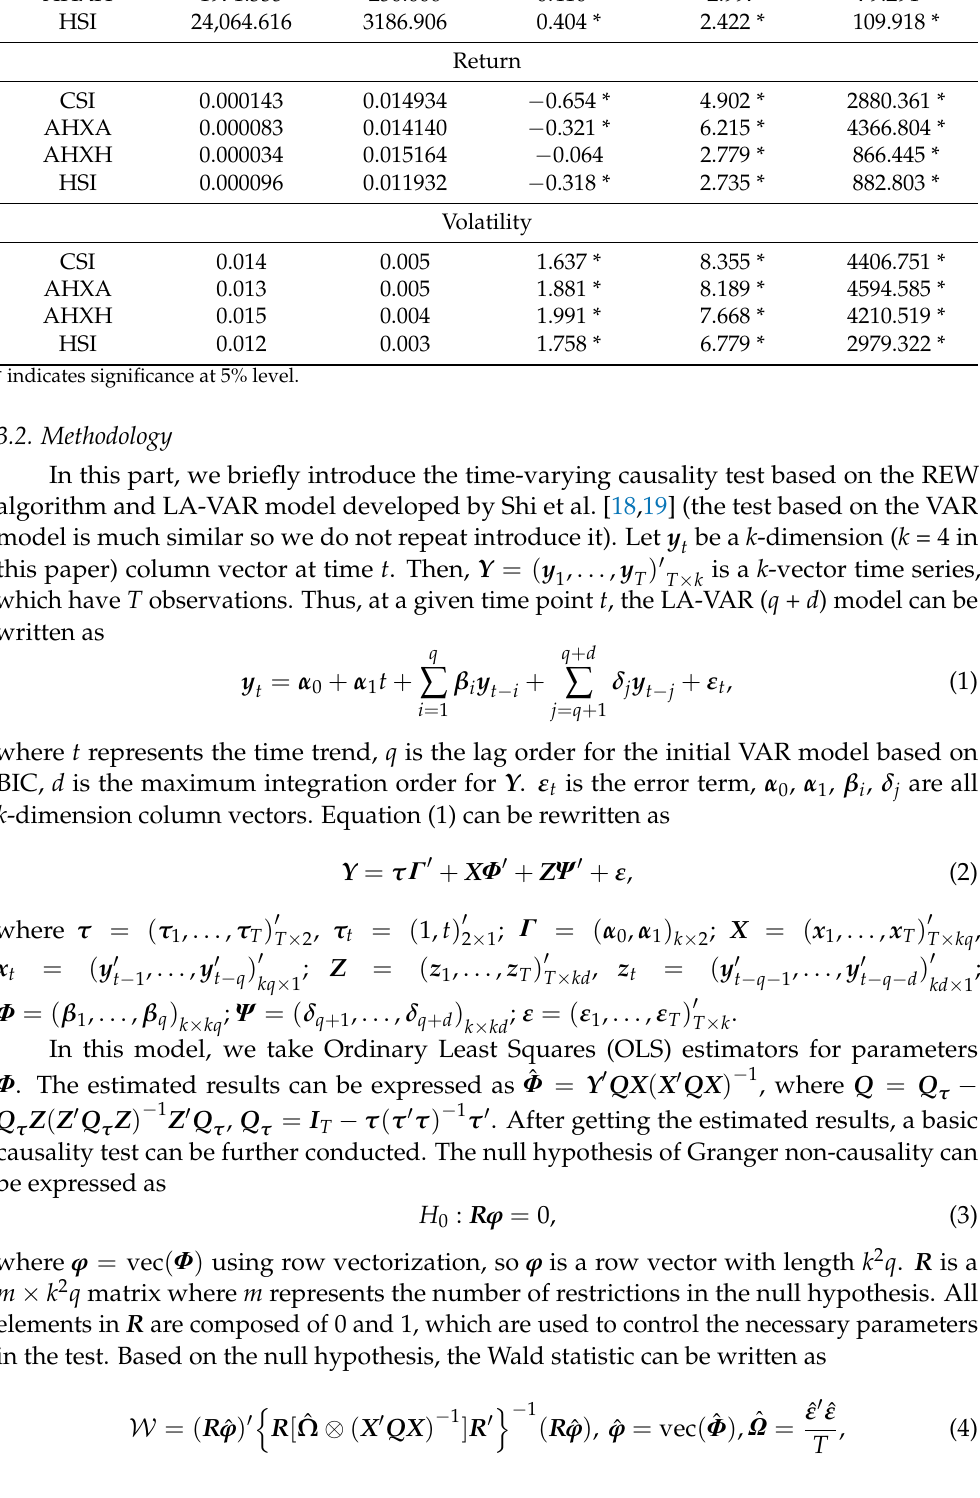
Table 2. Descriptive statistics.